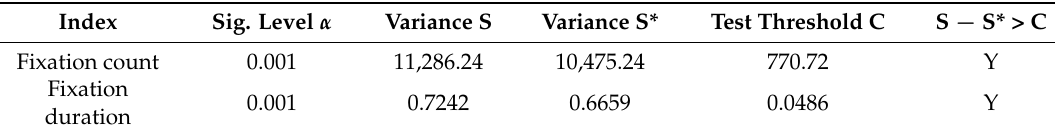
Table 5. The hypothesis test results by the least squares method.